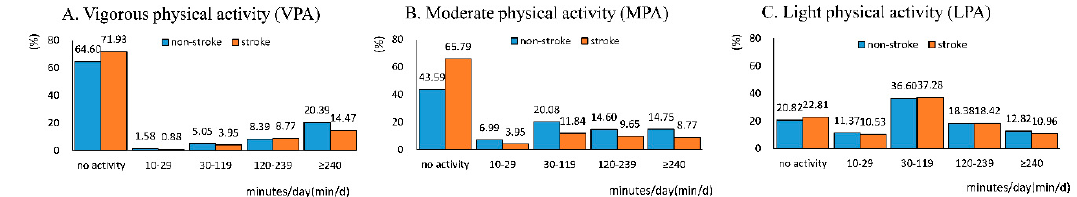
Figure 2. Duration of VPA ( A ), MPA ( B ), and LPA ( C ) in participants with and without a stroke. The height of the column represents the proportion of individuals at this level of duration in total participants with and without a stroke, respectively. Corresponding proportion is shown above the column.